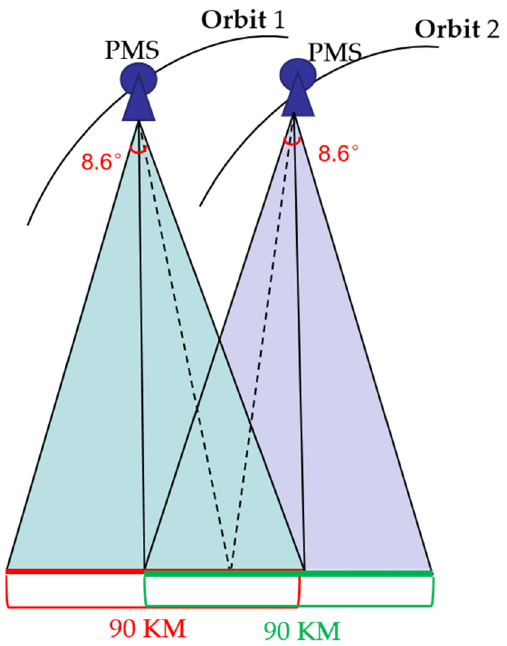
Figure 1. Schematic of obtaining stereo images using GF-6 high-resolution camera.